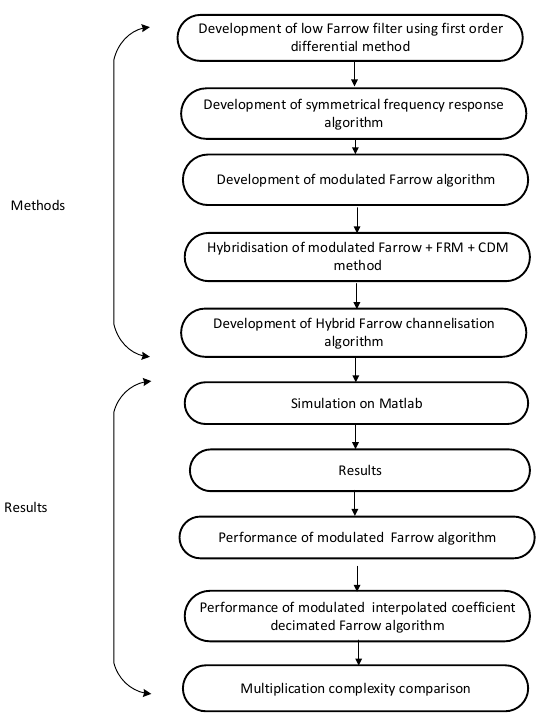
Figure 1. Flowchart depicting the HFarrow